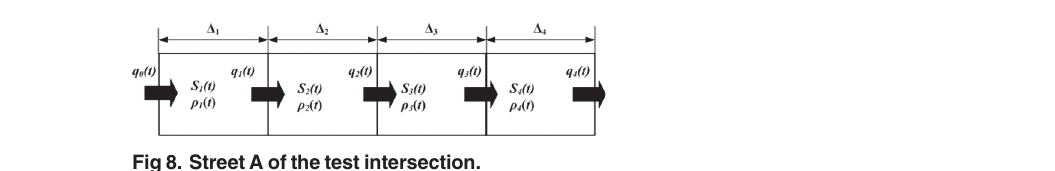
Fig 8. Street A of the test intersection.